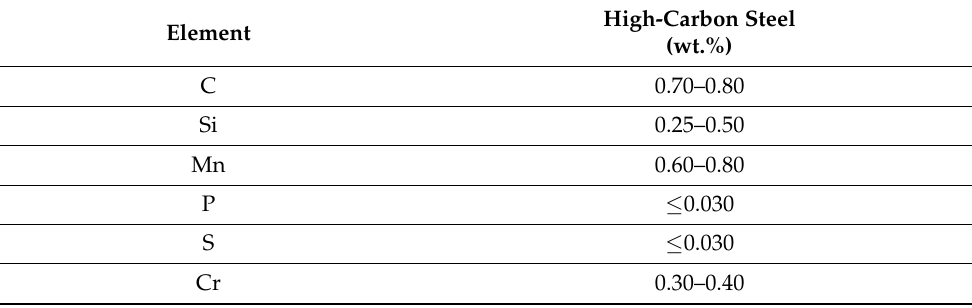
Table 1. Chemical composition of the high-carbon steel.